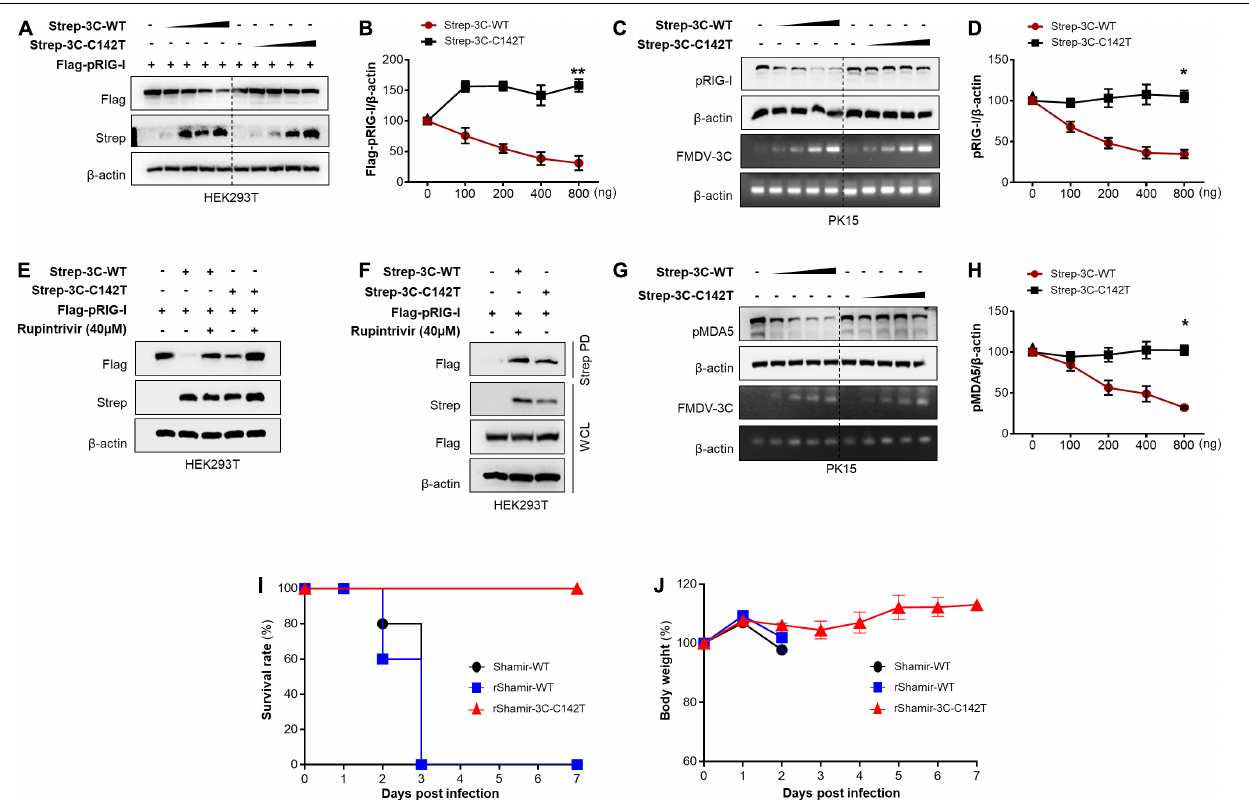
FIGURE 5 | FMDV 3C pro C142T is not involved in RIG-I and MDA5 degradation. (A) HEK293T cells were transiently transfected with Strep-tagged wild-type FMDV 3C pro or 3C pro C142T plasmids in a dose-dependent manner, or control plasmid, together with Flag-tagged porcine RIG-I plasmid. Cell lysates were subjected to immunoblotting with individual antibodies against Flag, Strep, and β -actin, and (B) band intensity was measured. (C) PK15 cells were transiently transfected with Strep-tagged wild-type FMDV 3C pro or 3C pro C142T plasmids in a dose-dependent manner, or control plasmid. Cell lysates were subjected to immunoblotting with individual antibody against RIG-I, or β -actin, following the qRT-PCR for FMDV 3C pro , 3C pro C142T, and β -actin, and (D) band intensity was measured. (E) HEK293T cells were transfected with a control plasmid, or Strep-tagged wild-type FMDV 3C pro , or 3C pro C142T plasmid, together with a Flag-tagged porcine RIG-I plasmid in the absence or presence of Rupintrivir. (F) HEK293T cells were transiently transfected with Flag-tagged porcine RIG-I plasmid, control plasmid, or Strep-tagged wild-type FMDV 3C pro or FMDV 3C pro C142T plasmid, and subsequent treatment of Rupintrivir into the selected combination. Cell lysates were subjected to Strep pull-down and immunoblotted with individual antibodies against Flag, Strep, and β -actin. (G) PK15 cells were transiently transfected with Strep-tagged wild-type FMDV 3C pro or 3C pro C142T plasmids in a dose-dependent manner, or control plasmid. And EV71 virus was infected. Cell lysates were subjected to immunoblotting with individual antibodies against MDA5 or β -actin, following the qRT-PCR for FMDV 3C pro , 3C pro C142T, and β -actin, and (H) band intensity was measured. For the comparison of pathogenesis in adult mice, 7 weeks old C57 female mice were divided into three groups ( n = 5) and intraperitoneally infected with Shamir-WT, rShamir-WT or rShamir-3C-C142T at a concentration of 5 × 10 4 . 0 TCID 50 /0.1 mL, and (I) survival rates and (J) body weight changes were measured. FMDV, foot-and-mouth disease virus; EV71, enterovirus 71; RIG-I, retinoic acid-inducible gene I; MDA5, melanoma differentiation-associated protein 5; qRT-PCR, real-time quantitative reverse transcription PCR; WT, wild-type. All the western blot data are representative of two independent experiments and the values are expressed as mean ± SD of at least two biological replicates. Student’s t -test; * p < 0.05; ** p < 0.01.